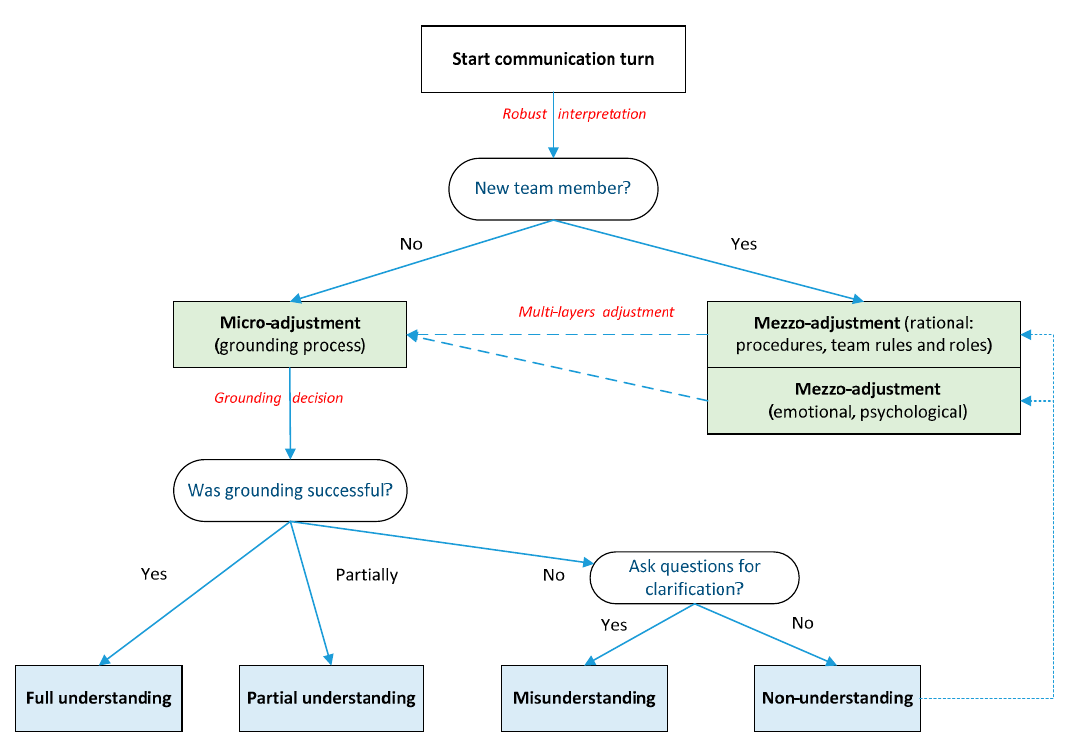
Figure 6. Model of adjustment processes at the micro- and mezzo-level of team communication.